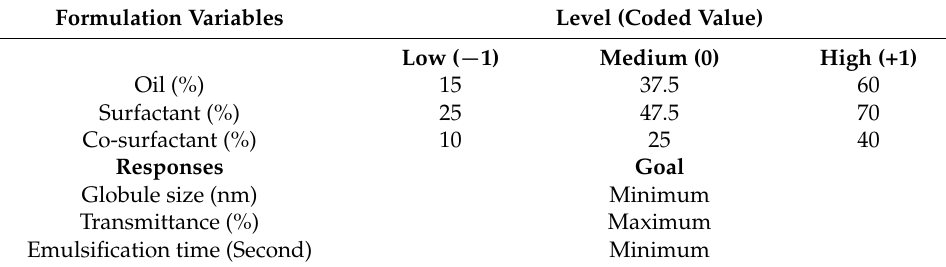
Table 1. Variables for Box-Behnken design